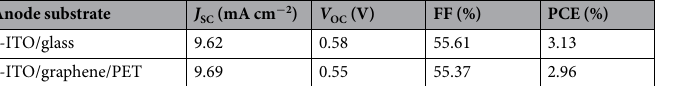
Table 1. Performance of PSCs fabricated with c-ITO/graphene/PET and c-ITO/glass as the anode materials using the 60-nm-thick c-ITO